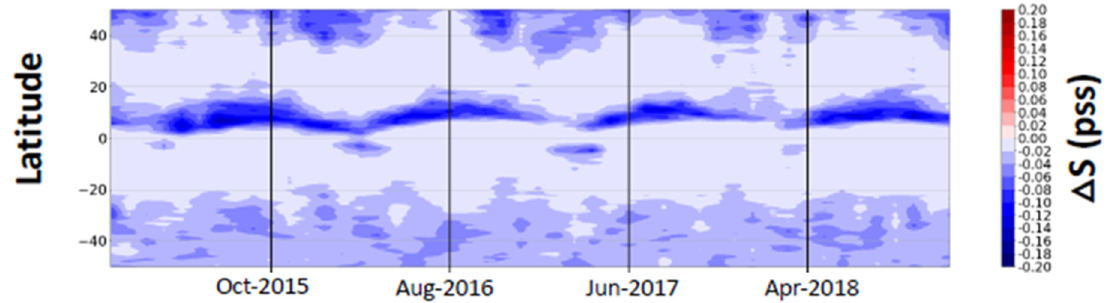
Figure 8. The latitudinal SSS decrease due to Rain Rate (RR) events, estimated from IMERG RR and a ∆ S-RR relationship similar to Figure 3 of [14].